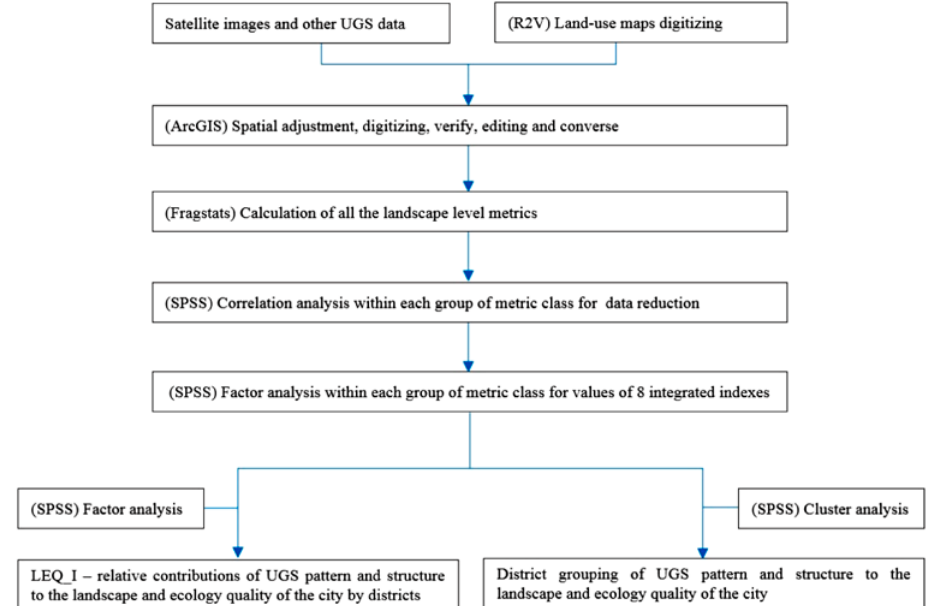
Fig. 2. Methodology chart